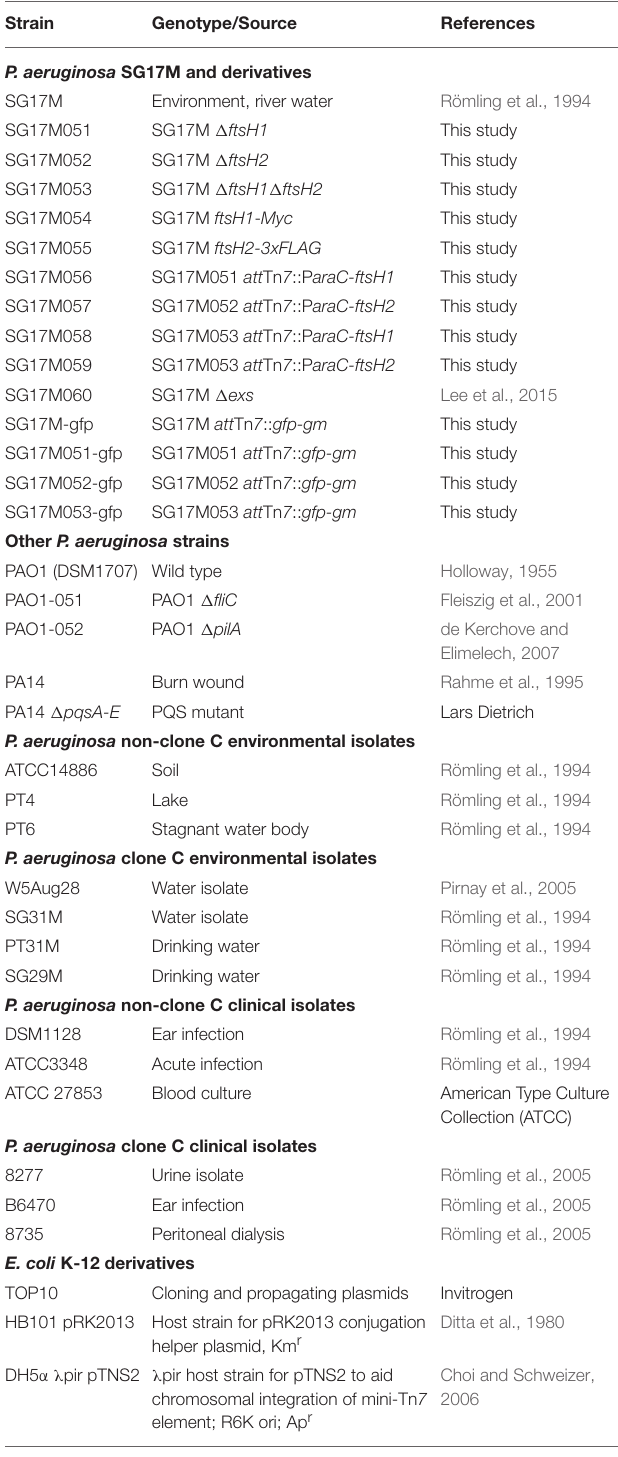
TABLE 1 | Bacterial strains used in this study.